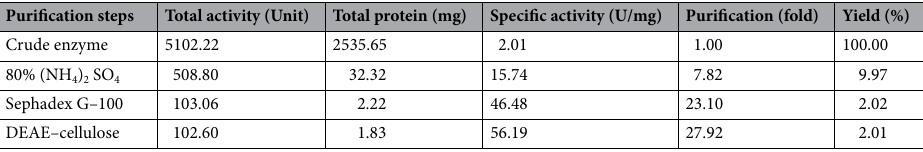
Table 1. Summary of the purification of xylanase from Thermomyces dupontii KKU–CLD–E2–3.